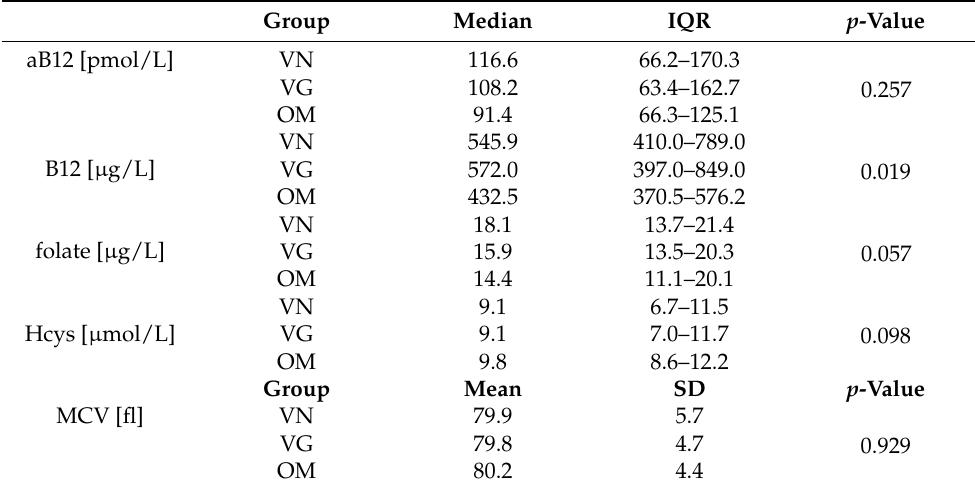
Table 7. Values of selected blood markers across VG/VN/OM groups.